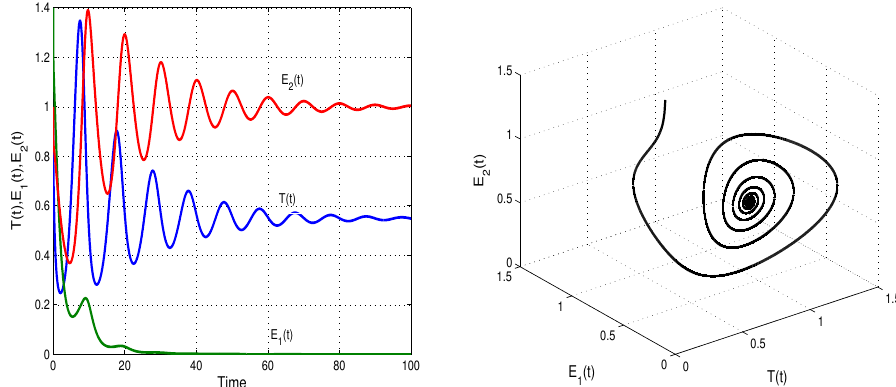
Figure 2. Left banner displays the numerical simulations of the deterministic model (1) when the conditions given in (5) are satisfied ( a = 1, r 1 = r 2 = 1, k 1 = 0.7, k 2 = 0.3, d 1 = 0.7 > d 2 = 0.3 and d 2 < 1). Right (top and bottom banners): the relation between the tumor cells T ( t ) and effector cells E 1 ( t ) , E 2 ( t ) . The endemic state is locally asymptotically stable.